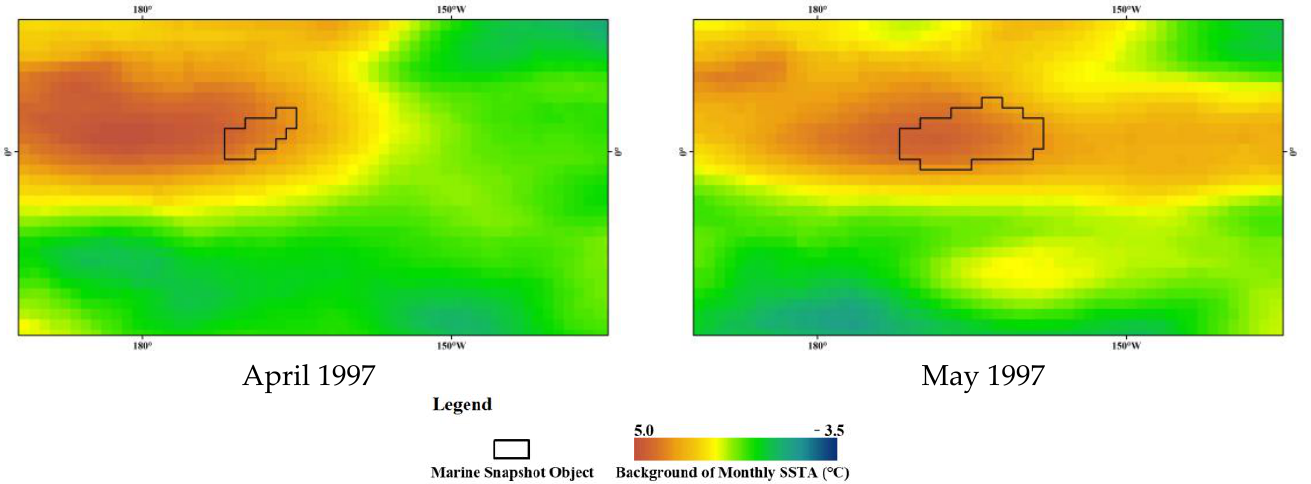
Figure 9. Sequence object 2 originates and expands in the Equatorial Central Pacific Ocean from April to May 1997. The background is the monthly SSTA.